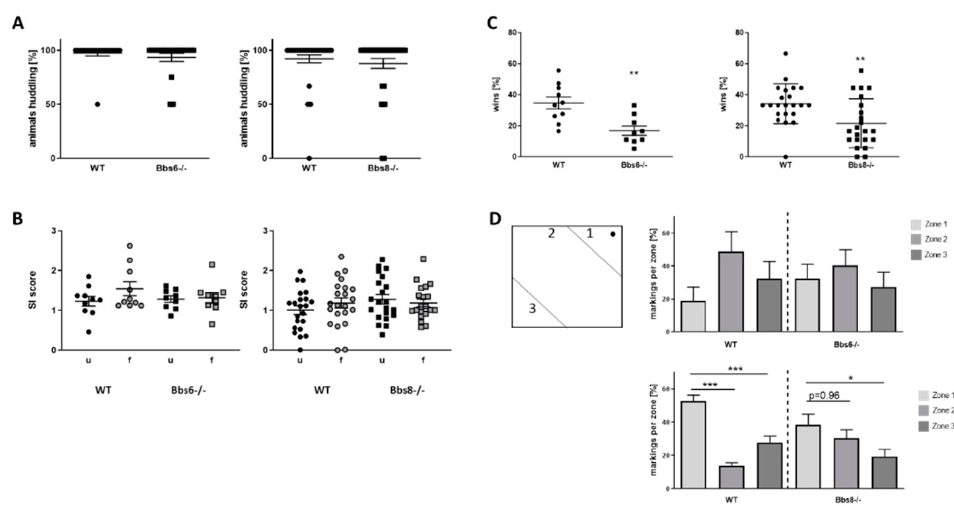
Figure 3. Social behavior of Bbs6 and Bbs8 knockout mice. ( A ) The number of mice huddling while sleeping was assessed ( n = 19 observed events for WT and Bbs6 − / − and n = 36 and 34 for WT and Bbs8 − / − ). ( B ) Social interaction with an unfamiliar (u) or a familiar (f) conspecific within a plexiglas cylinder was measured and set in relation to the time used to inspect an empty cylinder (social interaction (SI) score) ( n = 10 for WT and n = 9 for Bbs6 − / − ; n = 22 for WT and Bbs8 − / − ). ( C ) Dominance behavior was tested in the tube test with cage-mates ( n = 10 for WT and n = 9 for Bbs6 − / − ; n = 22 for WT and Bbs8 − / − ). ( D ) Urine scent marking was measured in the open field arena by stimulating male mice with pro-estrous female urine (wild type mouse). ( n = 16 events for WT and n = 21 events for Bbs6 − / − ; n = 36 events for WT and n = 25 events for Bbs8 − / − ). The scheme indicates the zone distribution within the open field arena and the applied female urine (black dot). Student’s unpaired t -test was used for statistical analysis (** p < 0.01) or one-way ANOVA with Sidak’s multiple comparison test (* p < 0.05; ** p < 0.01; *** p < 0.001)).